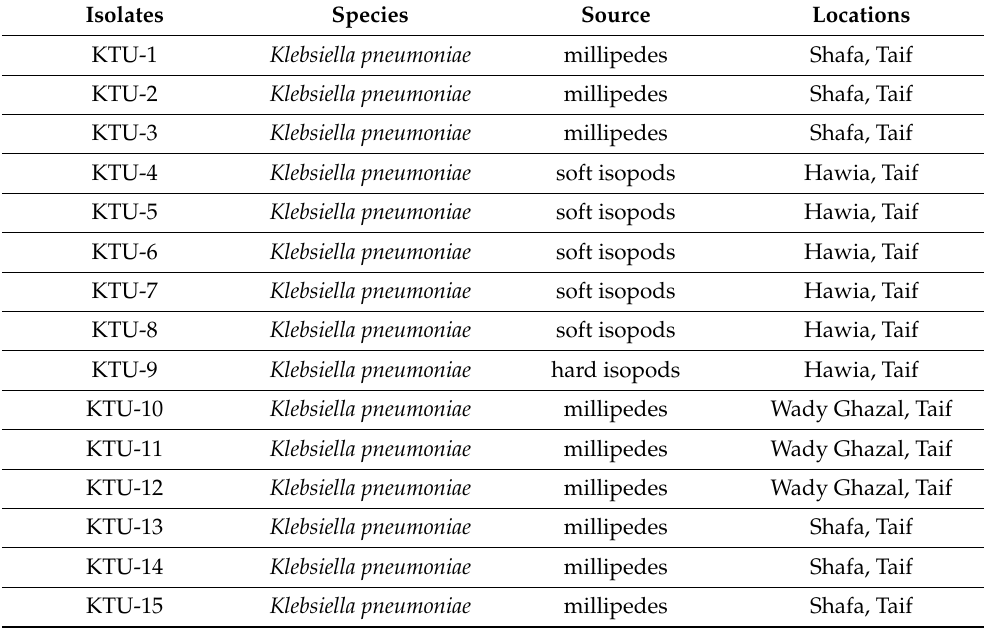
Table 1. Source and locations of Klebsiella pneumoniae that were isolated from some invertebrates in Taif, Saudi Arabia. Isolates Species Source Locations KTU-1 Klebsiella pneumoniae millipedes Shafa, Taif KTU-2 Klebsiella pneumoniae millipedes Shafa, Taif KTU-3 Klebsiella pneumoniae millipedes Shafa, Taif KTU-4 Klebsiella pneumoniae soft isopods KTU-5 Klebsiella pneumoniae soft isopods KTU-6 soft isopods soft isopods KTU-8 soft isopods hard isopods